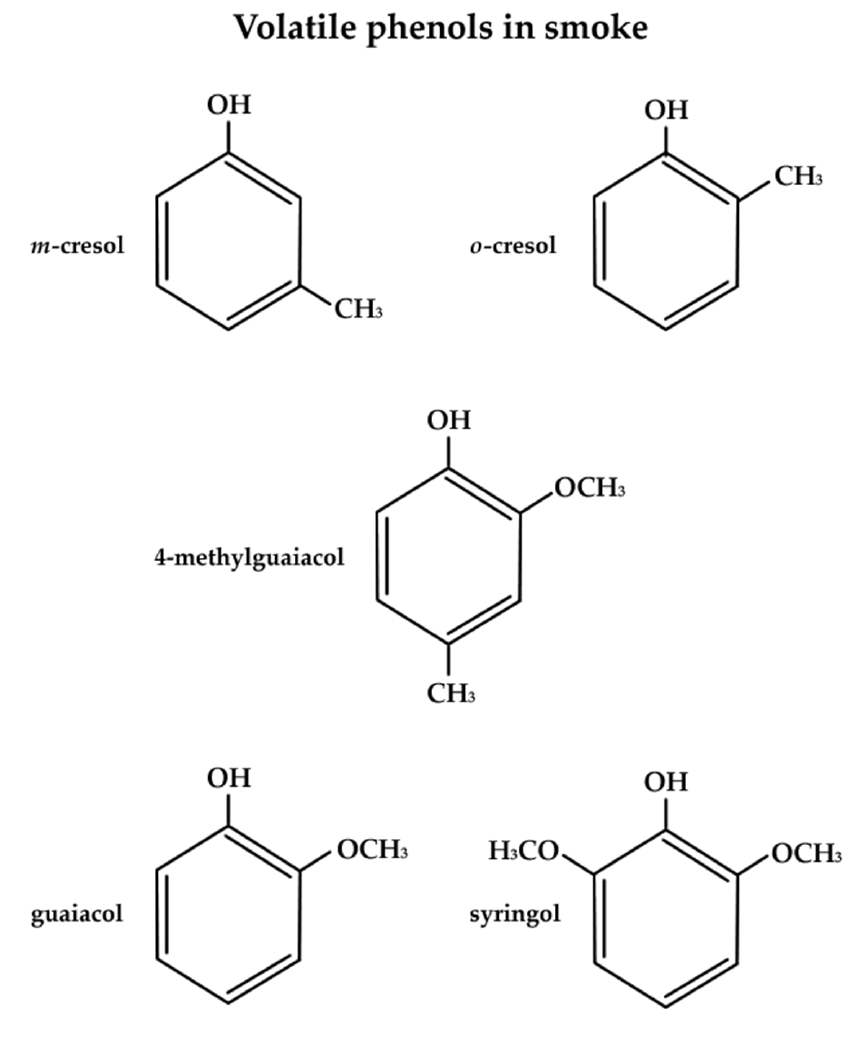
Figure 1. Chemical structures of some volatile phenols present in smoke [11,40–42]. Table 1. Aromas associated with certain volatile phenols present in smoke [11,36].